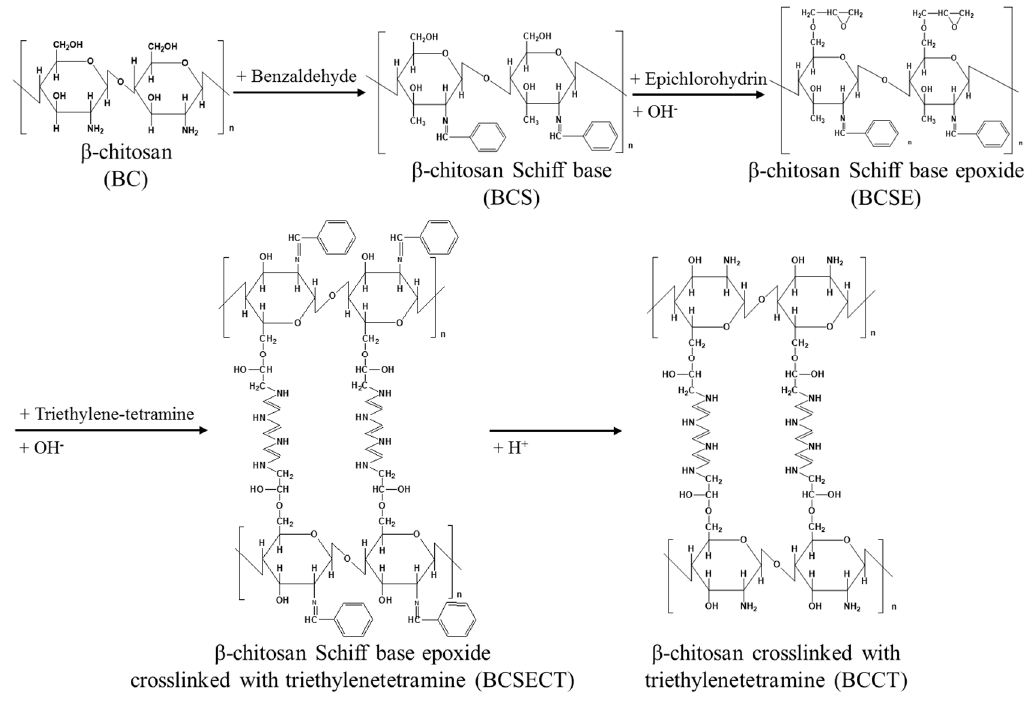
Figure 2. Synthesis route of the modified β -chitosan (i.e., β -chitosan cross-linked with triethylenetetramine (BCCT)) and its intermediate products.